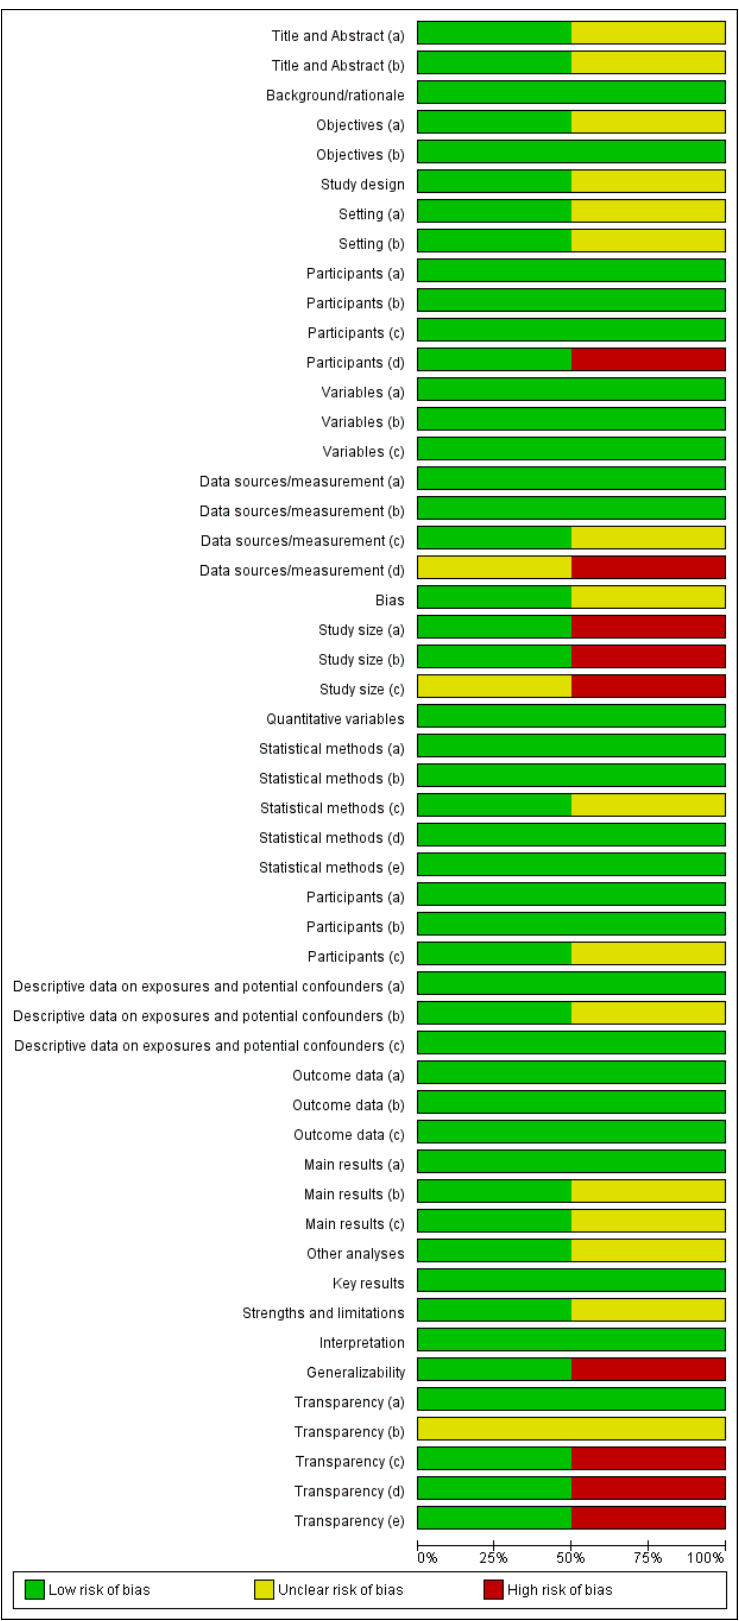
Figure 5. Reporting guidelines summary: review authors’ judgements about each criterion presented as percentage across all included